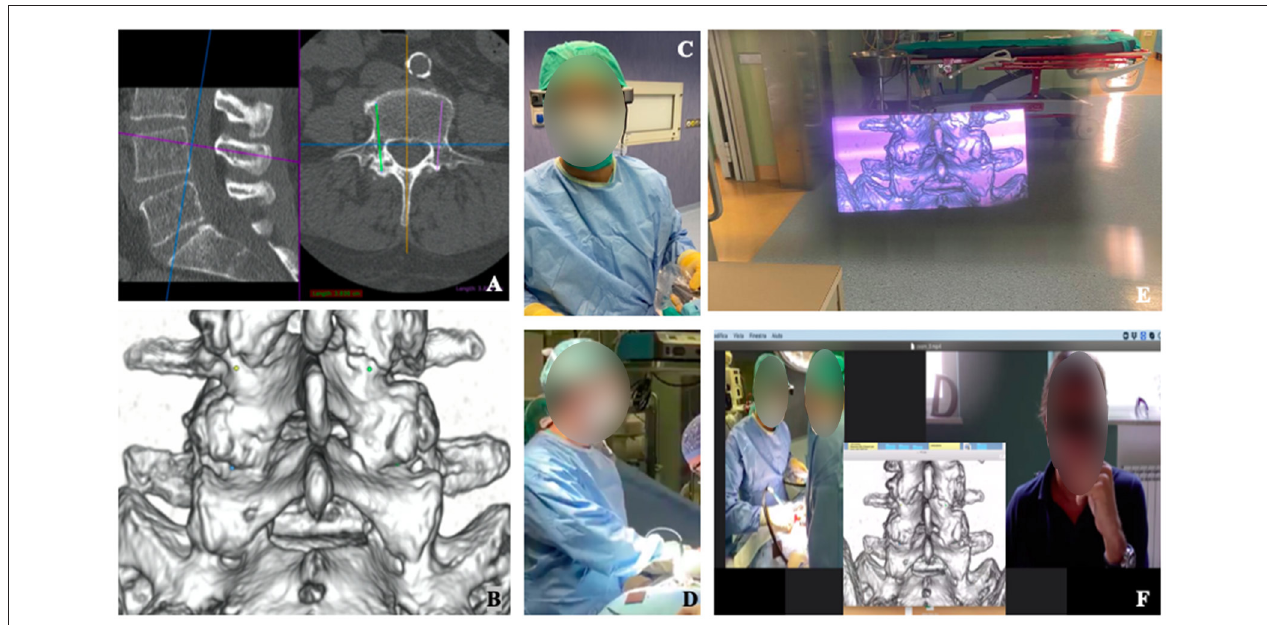
FIGURE 2 | Visualization of intra-operative 3D-model planning (A–D) . Surgical planning of screws positioning for lumbar spine fusion is shown (A) , with 3D reconstructed model highlighting the screws’ entry points (B) . Surgeon wore smart glass during surgery (C,D) and, with augmented reality, was able to see the 3D model wherever He preferred into the space (E) . The enhanced videoconference function with smart glasses’ screen sharing allowed participants to see through the eyes of the surgeon and communicate with him (F) .